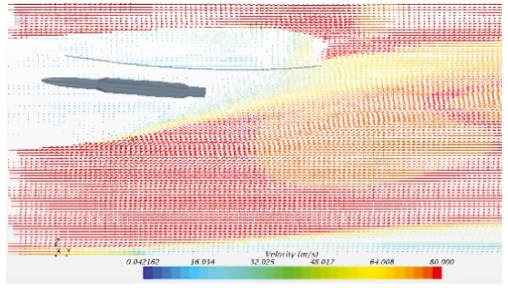
Figure 10: Flow fi eld velocity contour at 0 s.